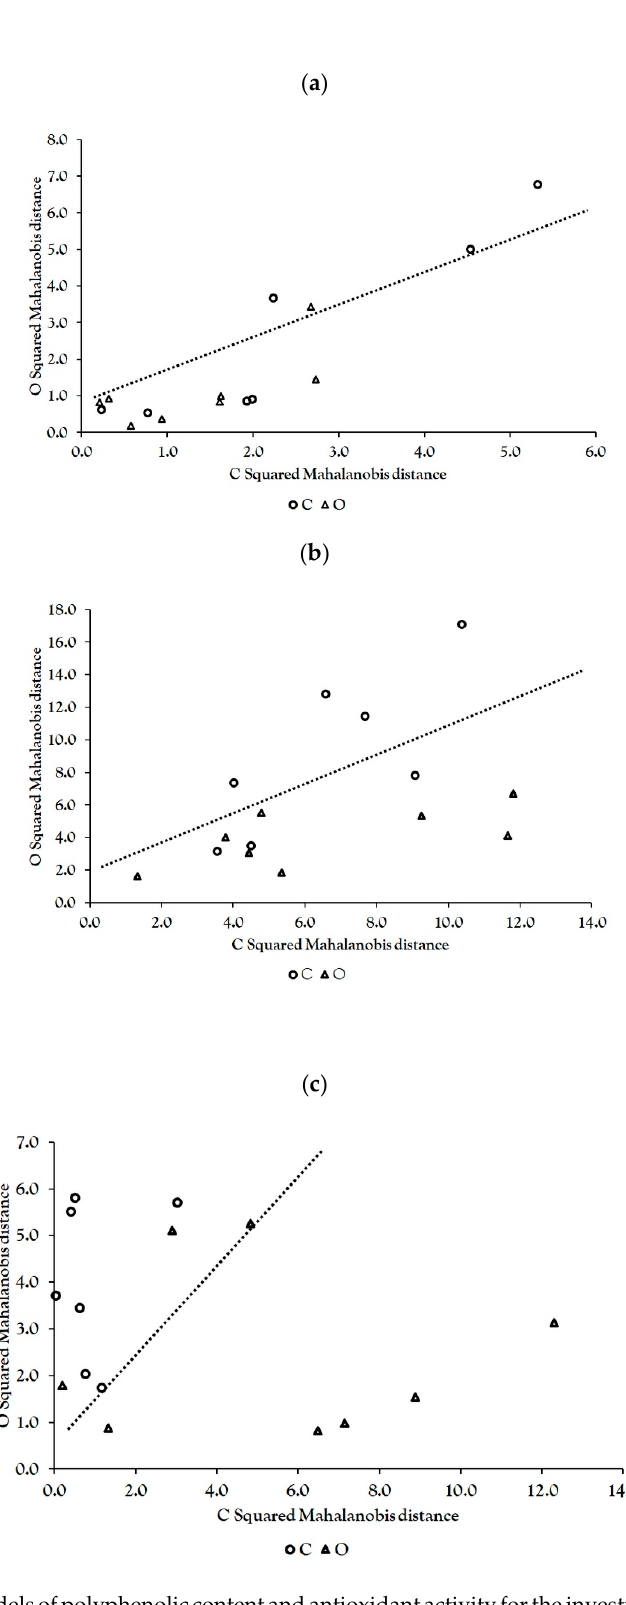
Figure 3. GDA models of polyphenolic content and antioxidant activity for the investigated conventional (CBW) and organic (OBW) group BW samples presented as squared Mahalanobis distances for each group; dotted lines separate predicted groups, and the triangles (OBW) and circles (CBW) represent the original membership to a group; ( a ) GDA1 ( b ) GDA2 and ( c ) GDA3.